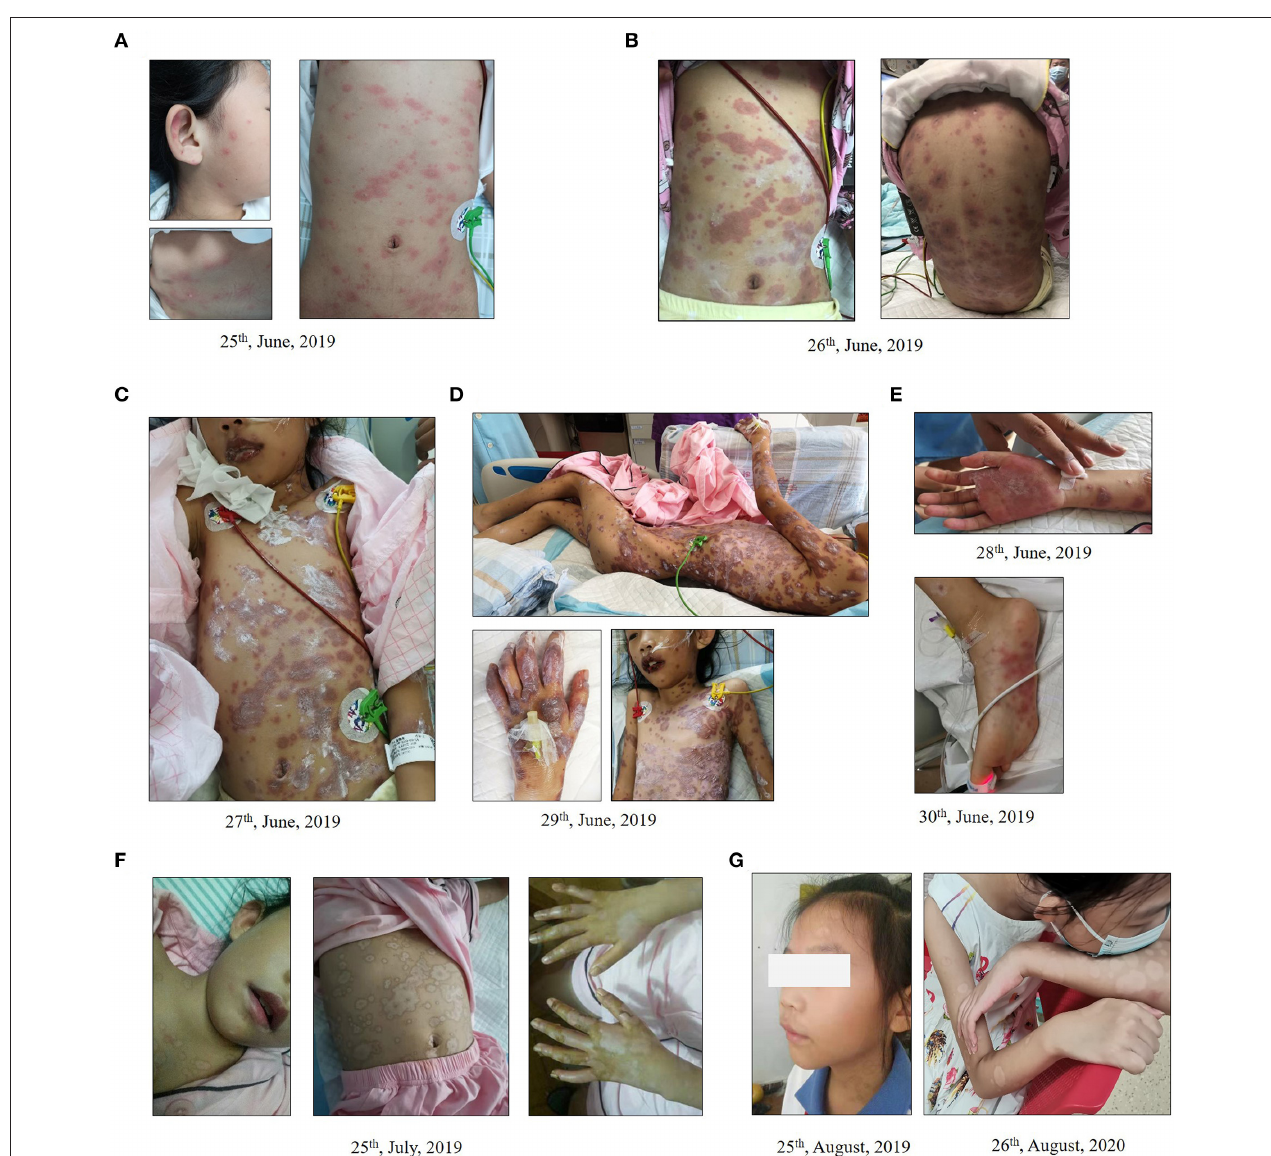
FIGURE 1 | Dynamic changes of erythema multiforme major in an 8-year-old Chinese girl. (A,B) Initiation (A) and progression (B) of erythema multiforme with painful blistering spread in the chest, back, and limbs of the child. (C–E) Cutaneous erythema was further exacerbated (C,D) and new rashes occurred on her hands and feet (E) . (F) Local ulcerations on lips and oral mucosa and systemic rash improved after 4 weeks of treatment. Rashes on the lower extremities and abdomen were scab-free. (G) Pigmentation persisted on her arms and shoulders where erythema multiforme had occurred during the follow-up visit after